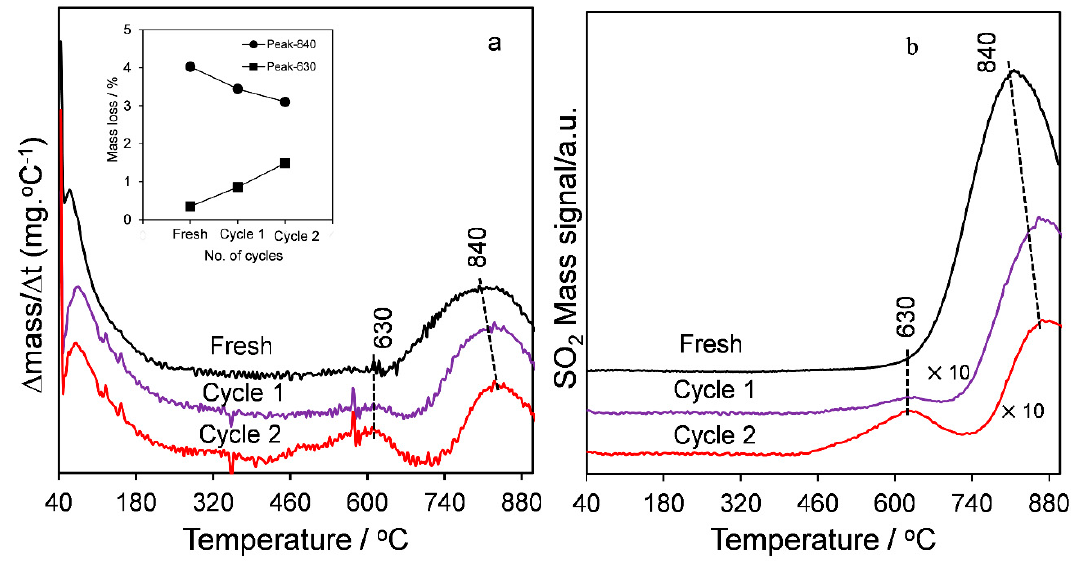
Figure 11. ( a ) DTG profiles, and ( b ) corresponding SO 2 desorption (m/z = 64) for fresh and spent 1.7 wt % SZ.